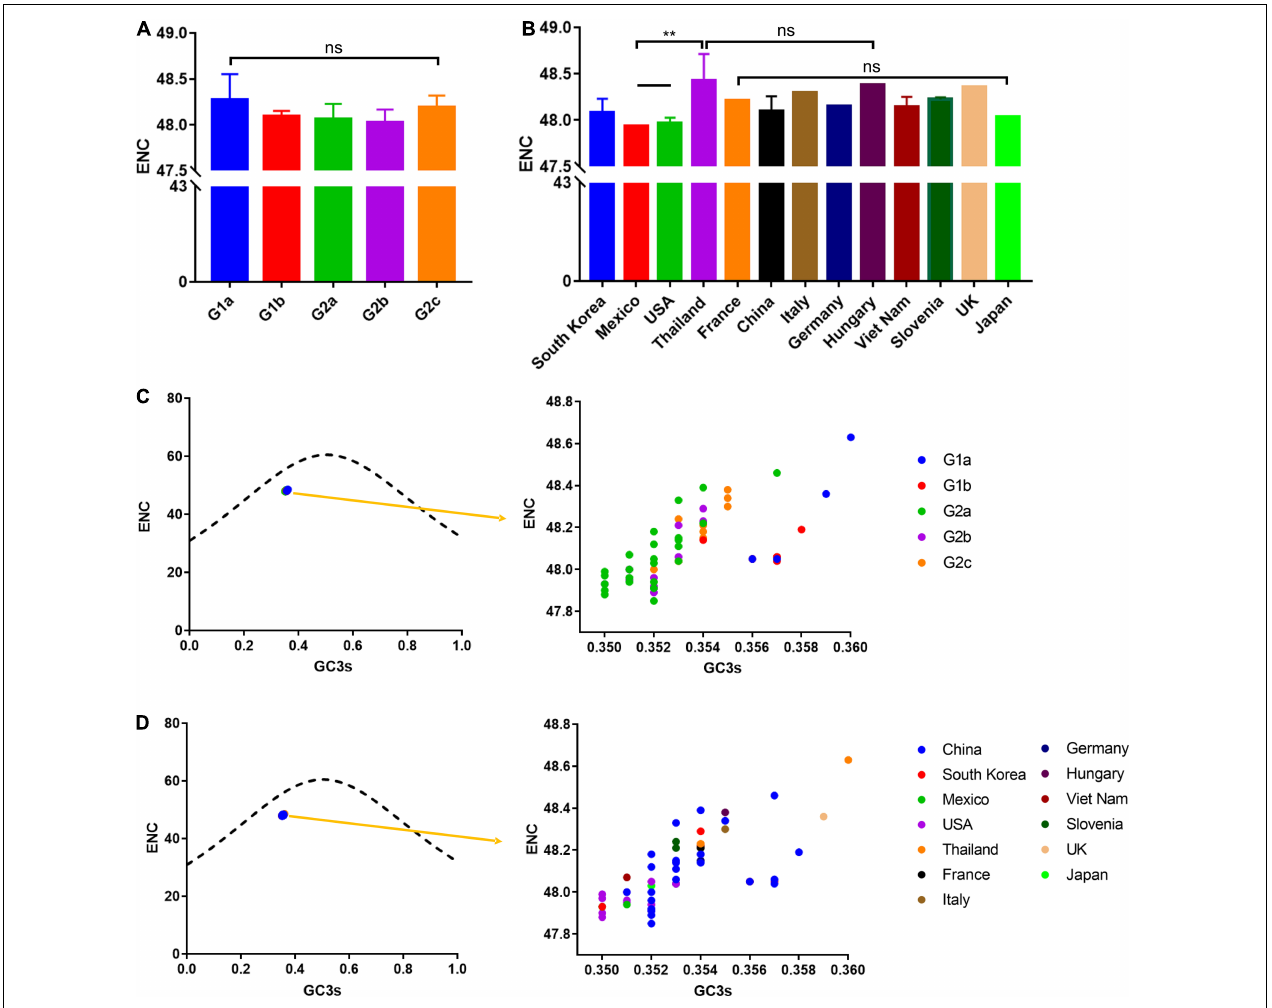
FIGURE 5 | ENC and ENC-plot analysis (GC3s plotted against ENC) of the PEDV complete coding sequence. (A) ENC value classified according to separate clades. (B) ENC value classified according to isolation nation. The relationships between effective number of codons (ENC) values and GC contents at the third codon position (GC3s) of synonymous codons are represented. (C) Points classified by phylogroups. (D) Points classified by isolation nation. The ENC of all PEDV isolates was clustered slightly below the solid curved line indicating selection pressure play a role on the PEDV codon usage pattern. Asterisk indicated the differential ENC value of PEDV between the indicated groups is significant ( p < 0.05). ns, not significant, p >